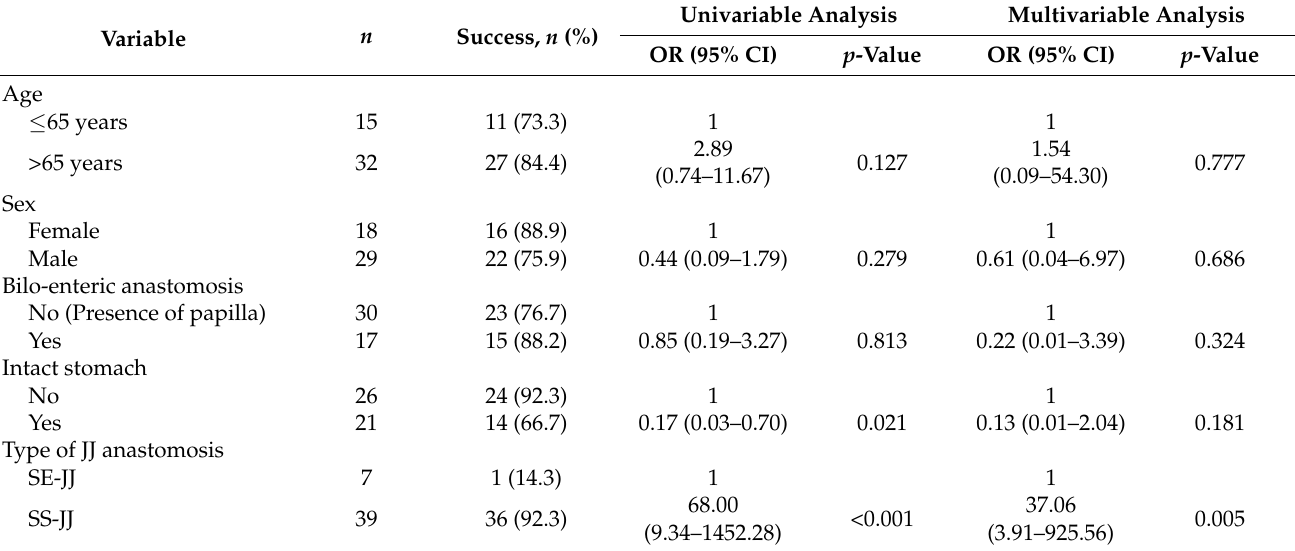
Table 3. Prediction of successful intubation using